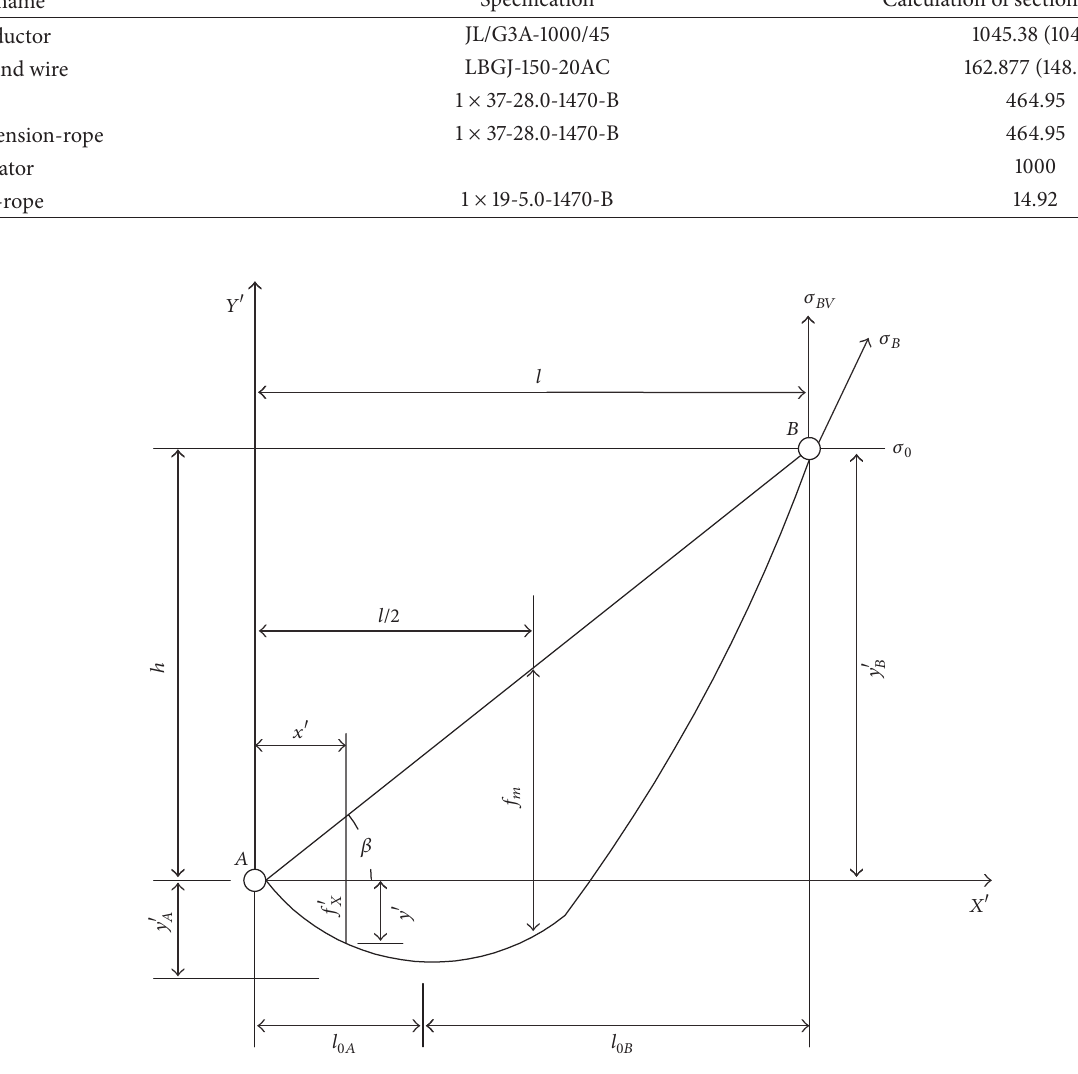
Figure 2: Calculation diagram of inclined